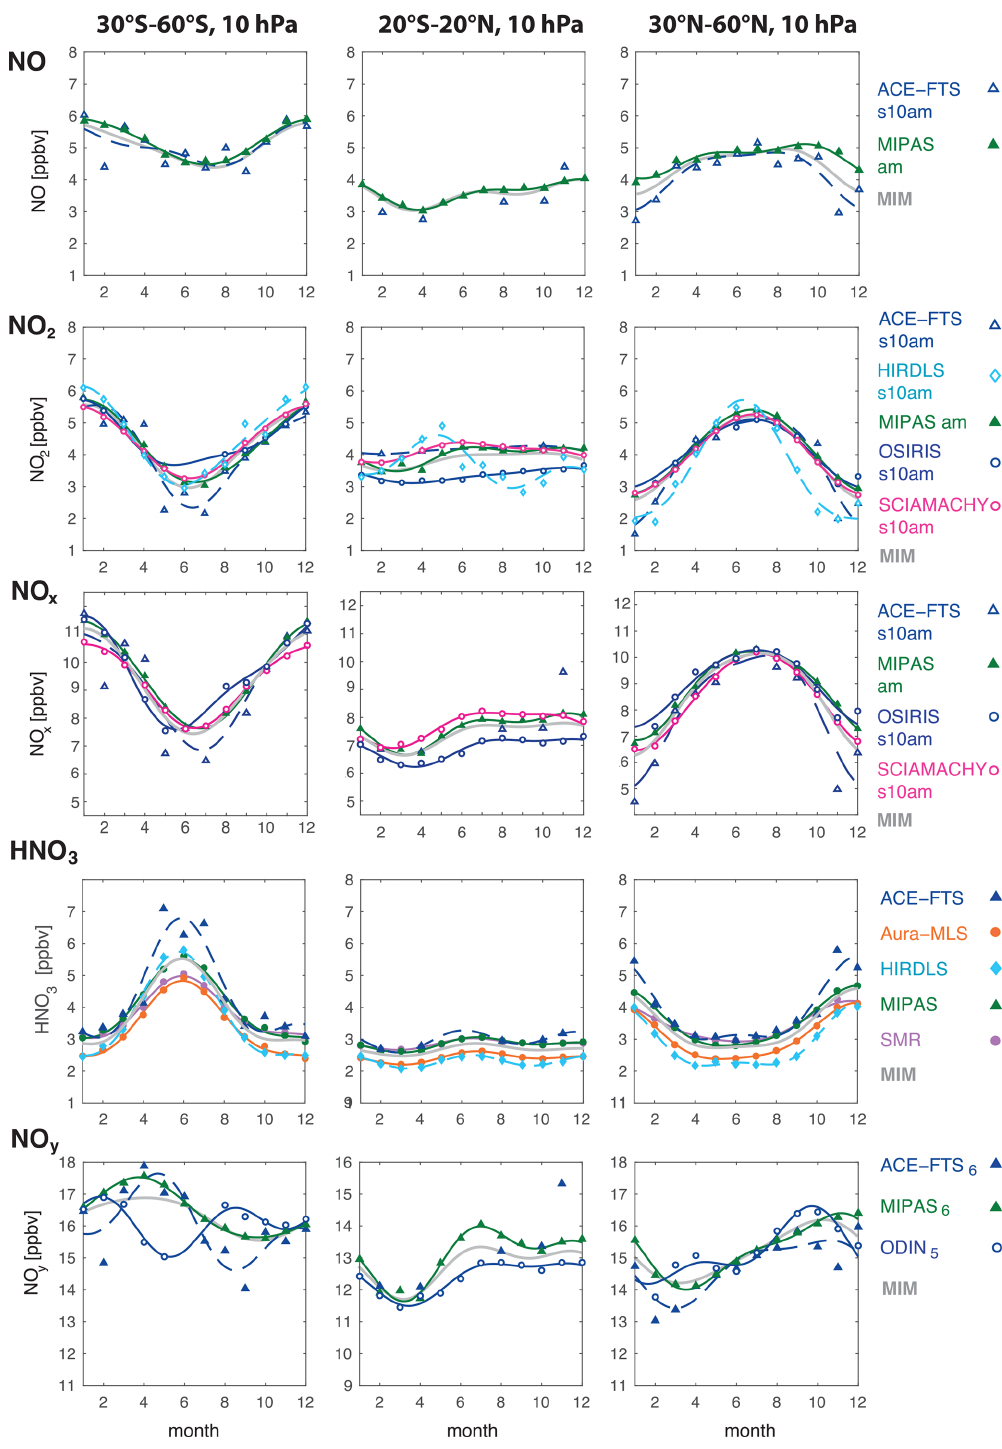
Figure 12. The seasonal cycle of NO, NO 2 , NO x , HNO 3 , and NO y is displayed for the SH midlatitudes (30–60 ◦ S, leftmost panels), the tropics (10hPa 20 ◦ S–20 ◦ N, middle panels), and NH midlatitudes (30–60 ◦ N, leftmost panels) at 10hPa for the time period 2005–2010. Note that the NO, NO 2 , and NO x seasonal cycles are based on 10:00LT datasets. The s10pm denotes datasets scaled to 22:00LT.